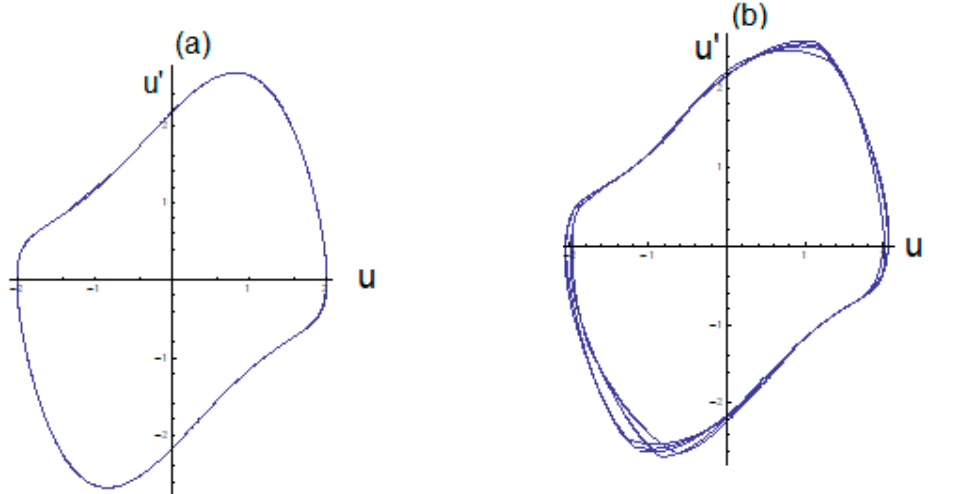
Figure 5. The limit cycles of van der Pol oscillator for ε = 1 and the step-size ( a ) h = 0.1, ( b ) h = 0.5 on